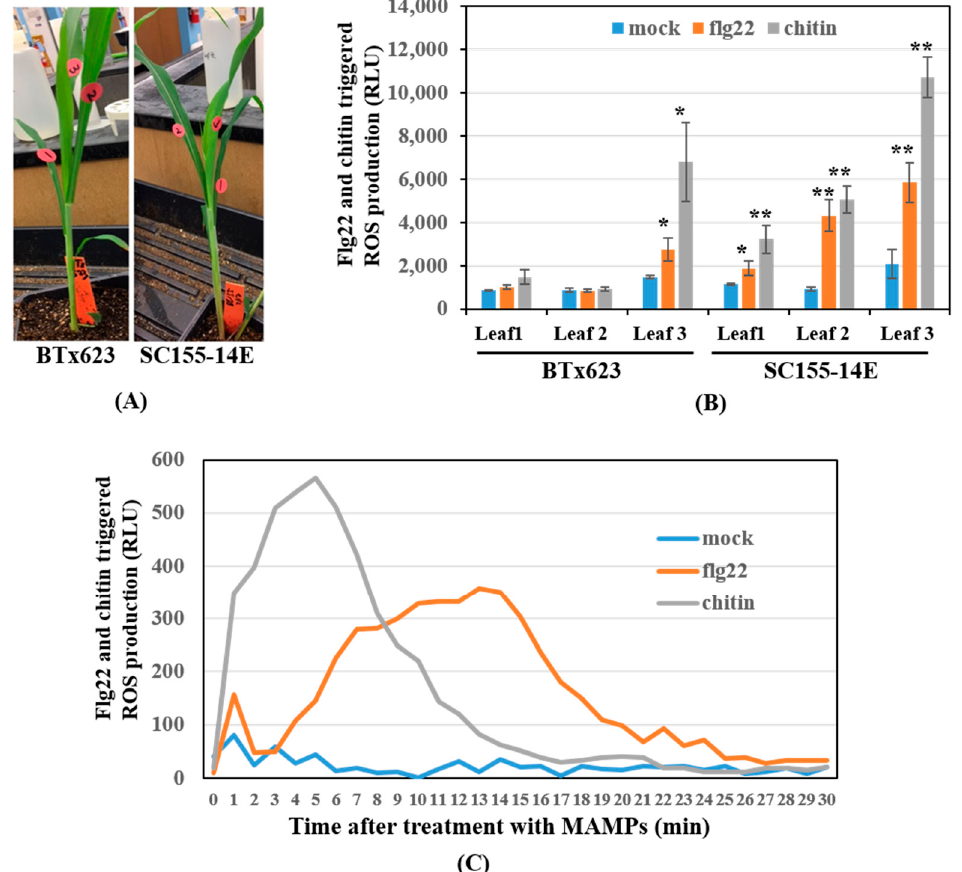
Figure 1. Effect of leaf position on the ROS response to MAMP elicitation in sorghum genotypes BTx623 and SC155-14E. ( A ) Fifteen-day old BTx623 and SC155-14E plants. The leaves from bottom to top were marked as leaf #1 (older leaf), leaf #2 (2nd youngest leaf) and leaf #3 (youngest leaf). ( B ) ROS response to flg22 or chitin elicitation of all three leaves of fifteen-day old BTx623 and SC155-14E plants. RLU, relative light units; Error bars indicate ± SEM; n = 8; * <0.05 ( t test) and ** <0.01. ( C ) Time course of flg22-triggered and chitin-triggered ROS production in leaf # 2 of SC155-14E.